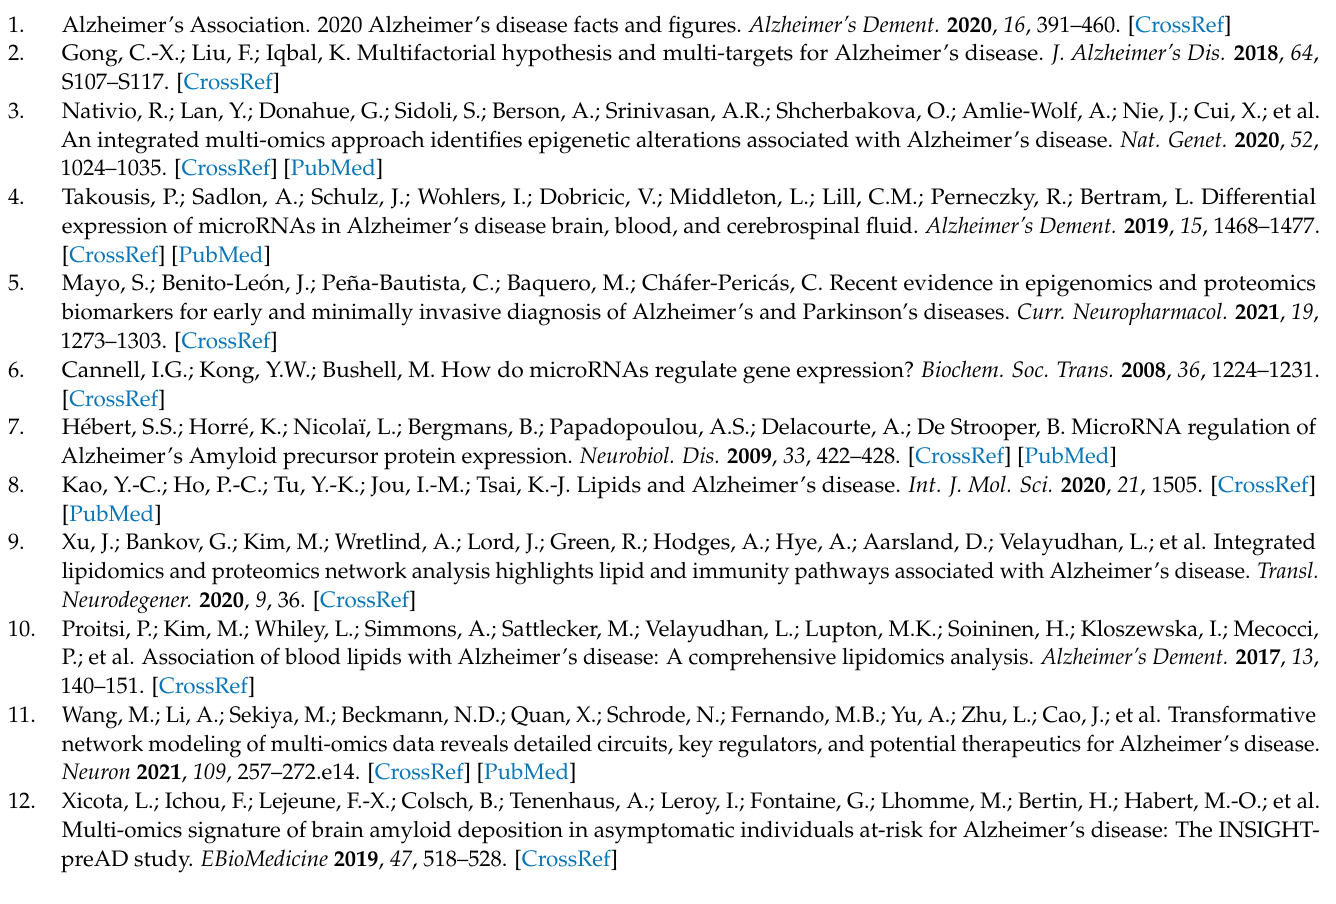
Table S1: Correlation matrix representing the individual correlation between miRNAs and lipids, Table S2: Median values for individual miRNAs and lipids in control and MCI-AD